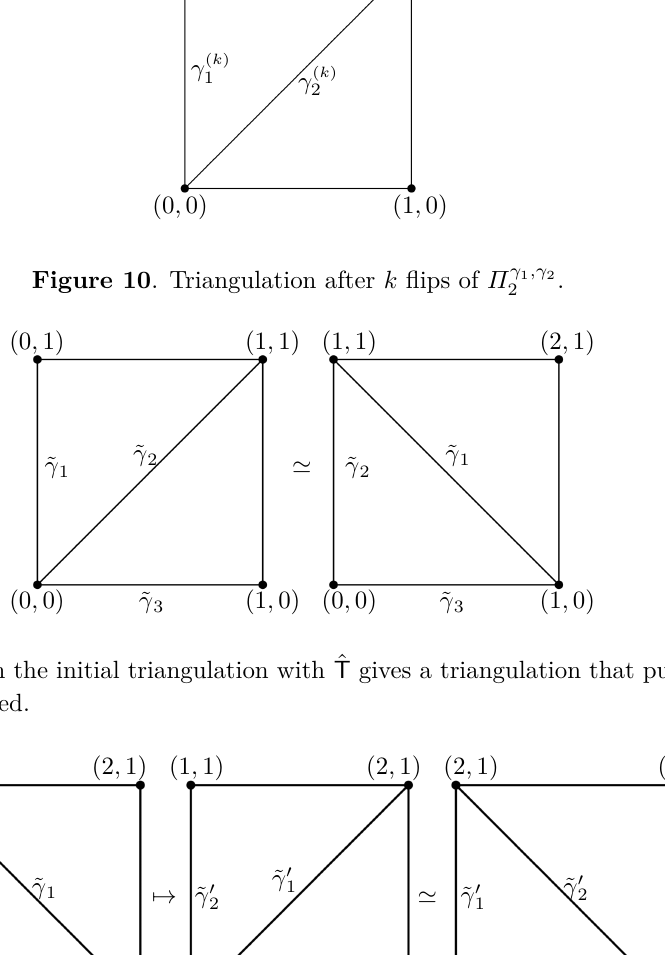
Figure 12 . We first unflip the edge corresponding to ˜ γ triangulation, now with ˜ γ 0